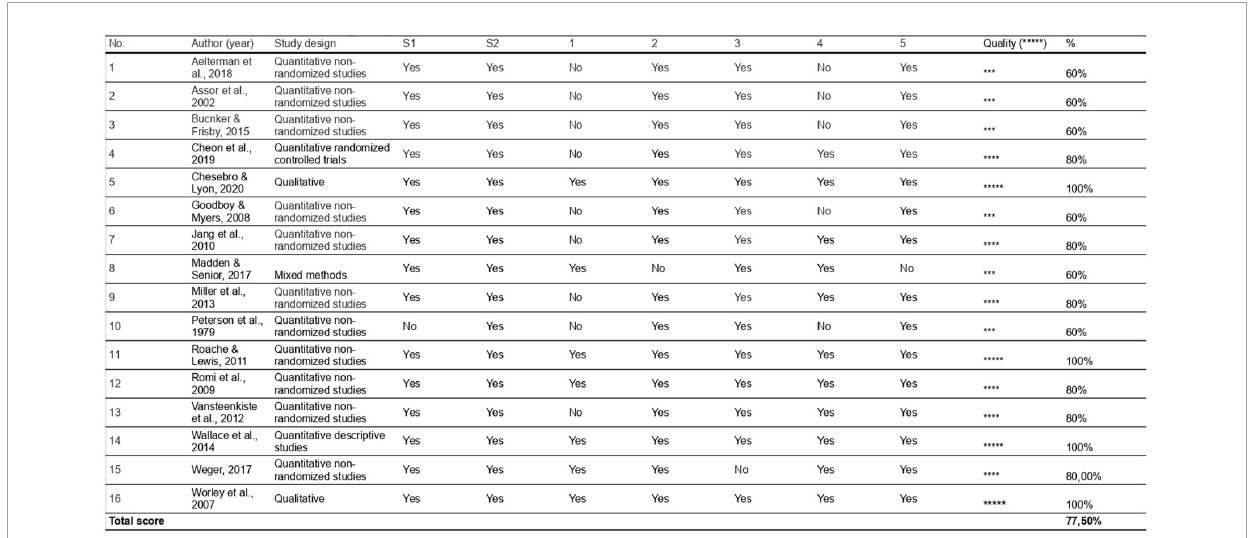
FIGURE2 Overview of the quality appraisal ratings using the